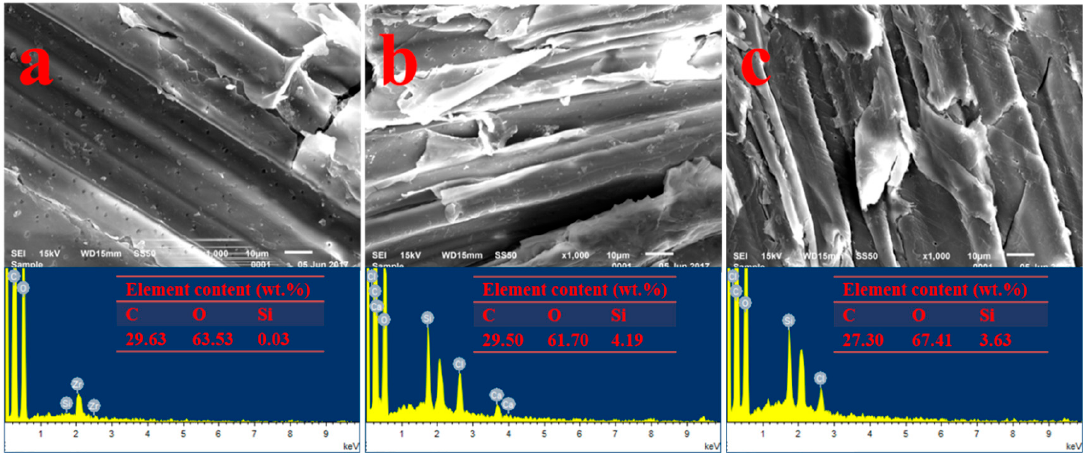
Figure 4. SEM images of SCB ( a ), fresh SCB-NH 2 ( b ), and recovered SCB-NH 2 ( c